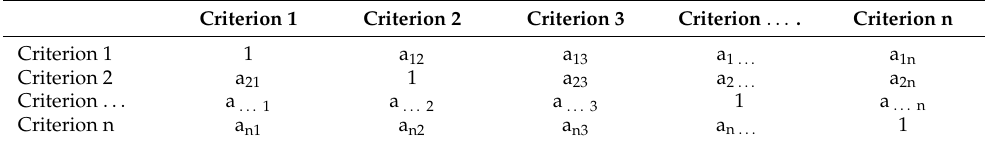
Table 4. Paired comparison matrix for criteria